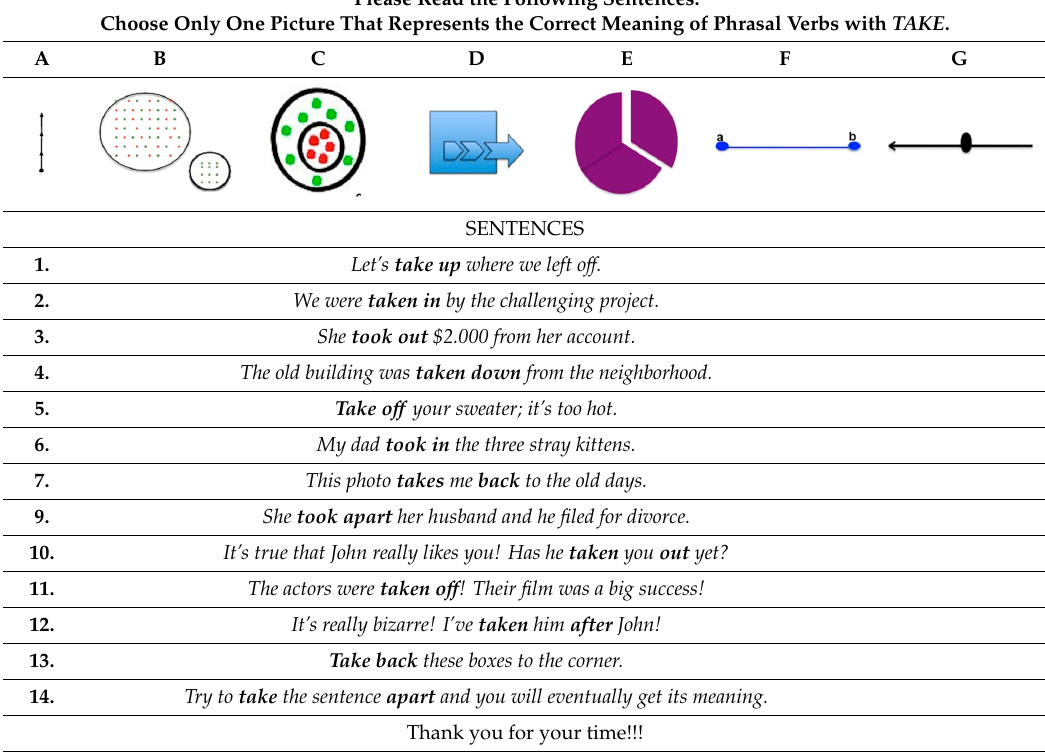
Table 8. The sentence-processing picture-matching task conducted during task 2. Please Read the Following Sentences.